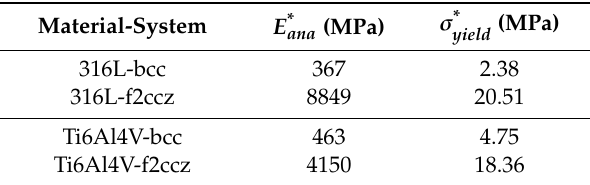
Table 6. Results obtained by the analytical model.